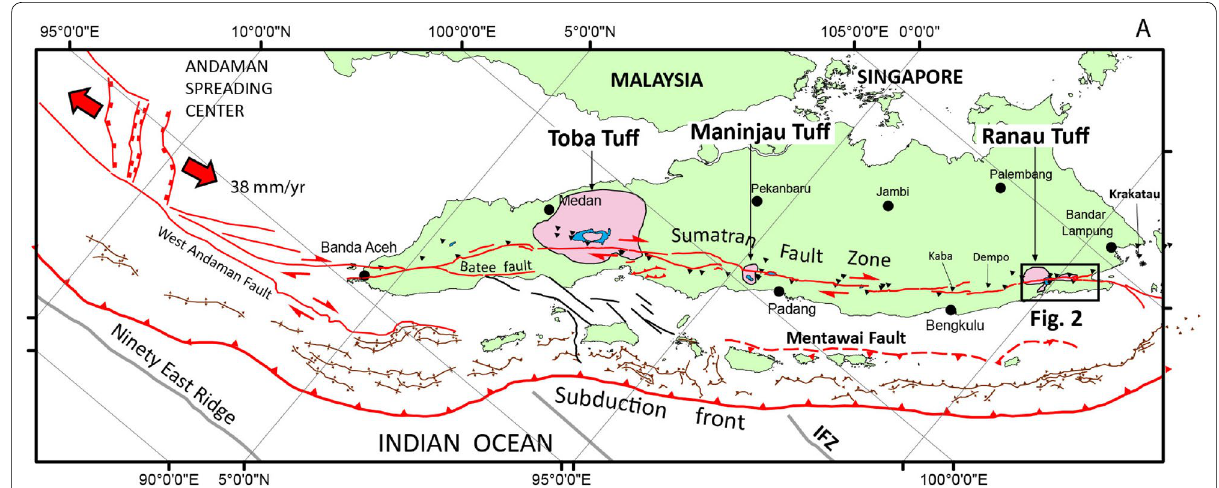
Fig. 1 Neotectonic setting of the Sumatran oblique convergent margin and locations of three large Quaternary rhyolitic tuffs along Sumatra Fault Zone. IFZ Investigator Fracture